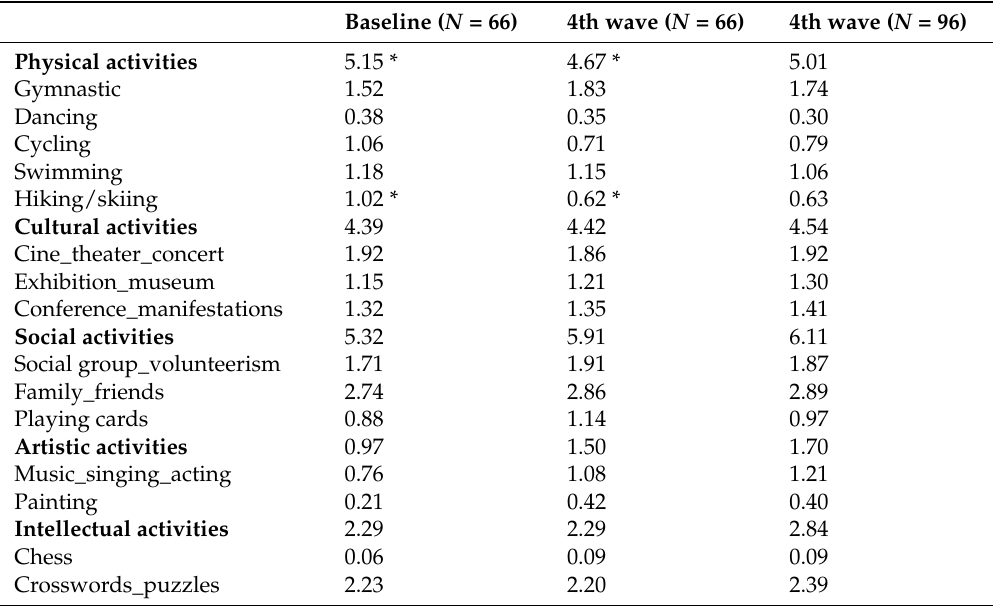
Table A1. Mean frequency of leisure activities engagement at different time points of the